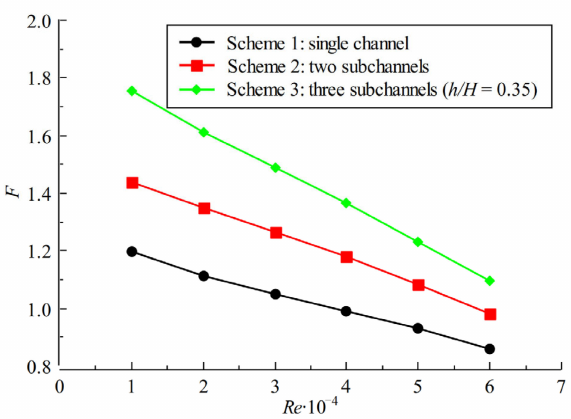
Figure 12. Comparison of comprehensive thermal performances of X-shaped truss array channels for different layout